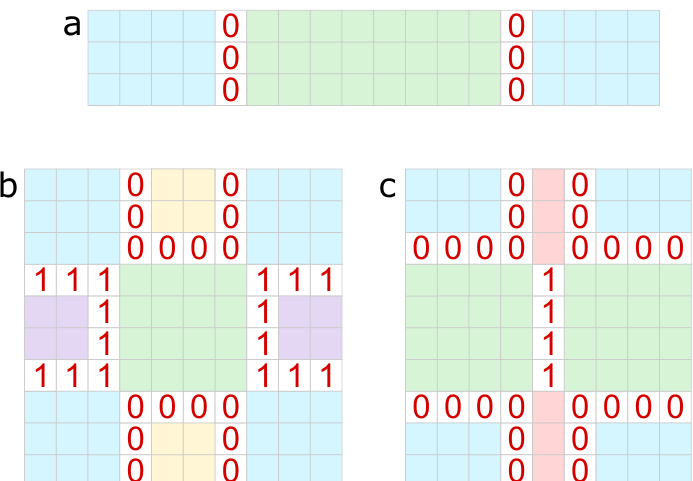
Figure 12: Examples of shielding structures separating the system into spatially dis- connected disentangled active regions (painted in different colors); p.b.c are as- sumed. (a) Two simple straight shields can separate the system into two active regions. (b, c) More complicated shielding structures, including “3-junctions". In (c), the spins in the region painted in solid red color can be chosen arbitrarily, but nevertheless will necessarily remain